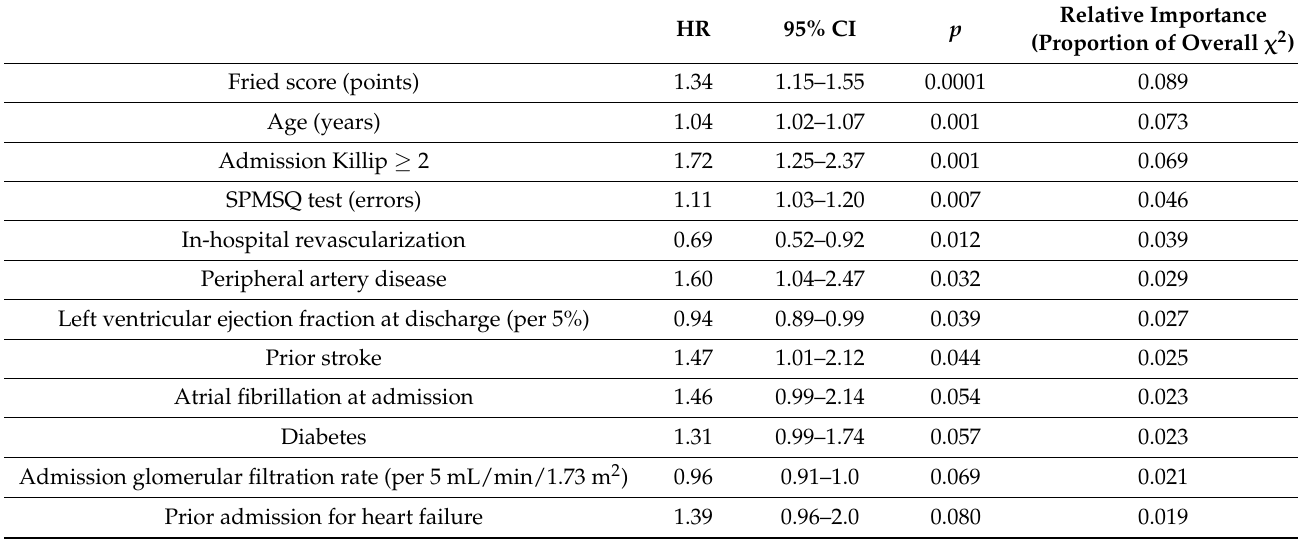
Abbreviations: HR = hazard ratio; CI = confidence interval. SPMSQ = Short Portable Mental Status